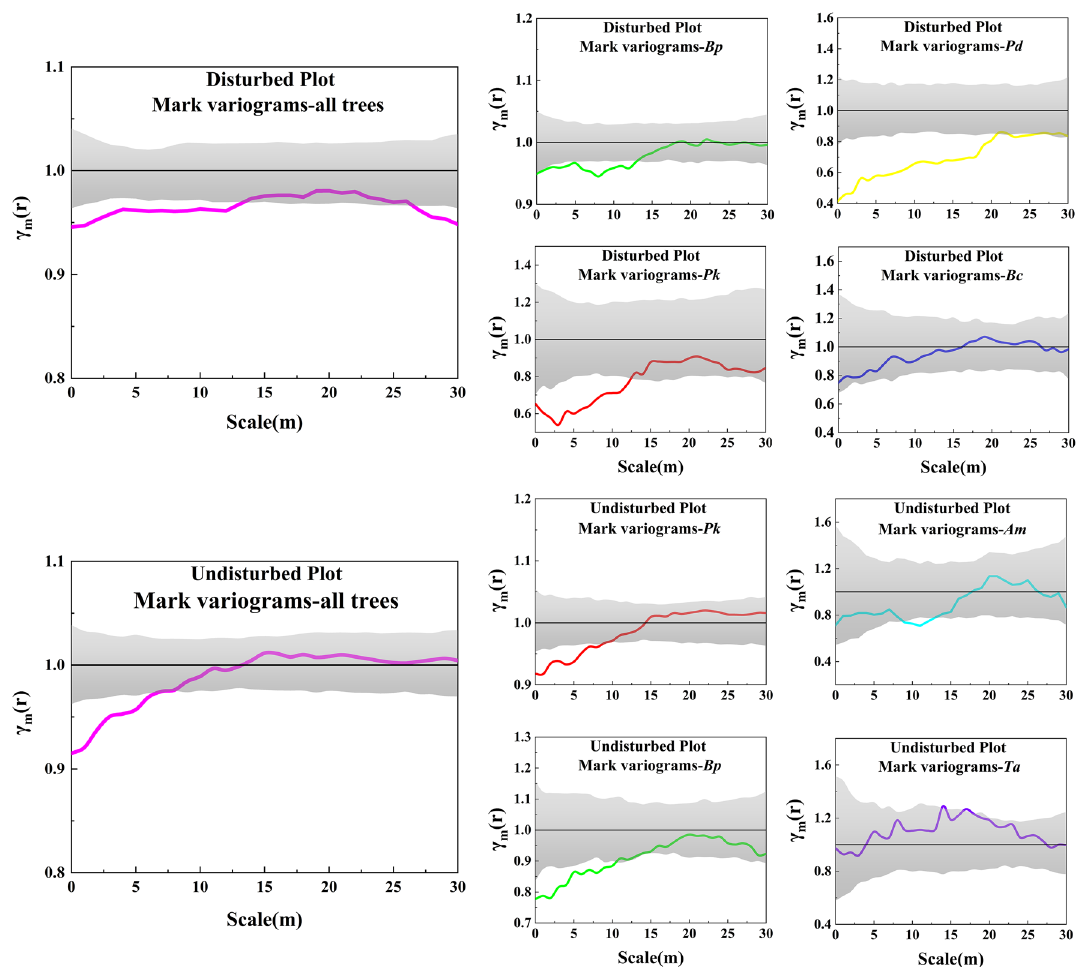
Figure 5. Mark variograms for dominant species in the disturbed and undisturbed plot. The Y axes represents the γ m ( r ) values, which is a measure of the similarity of the marks (here tree DBH) depending on the distance between points; the X axes represents the spatial distance scales. Black solid lines γ m = 1 correspond to the values for the case with independent marks. Different colored solid lines show actual γ m ( r ) values, where pink color represents all trees and gray shaded area indicates upper and lower of the limit 99% confidence